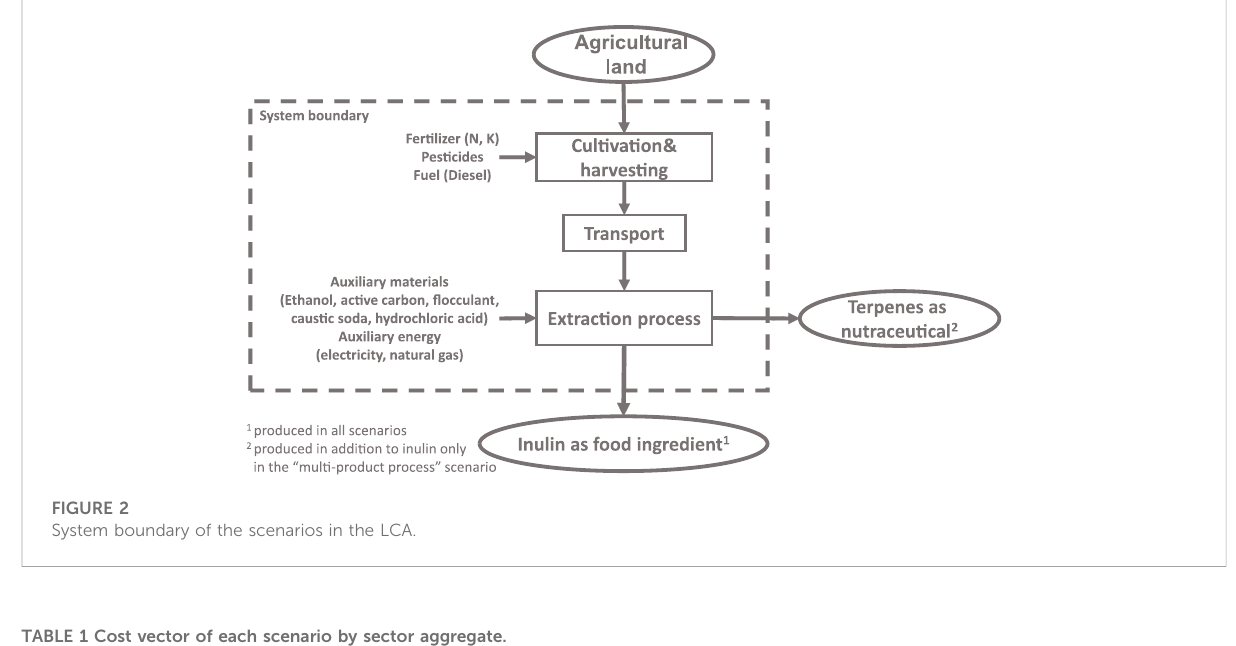
TABLE 1 Cost vector of each scenario by sector